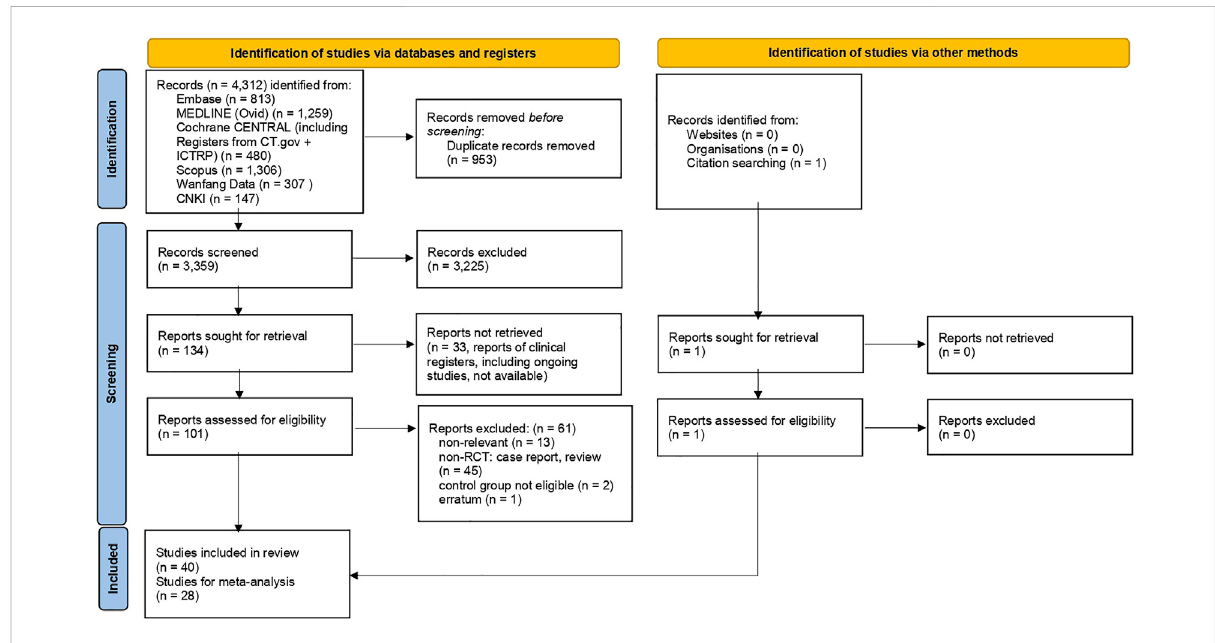
FIGURE 1 Study selection fl ow diagram based on the PRISMA 2020